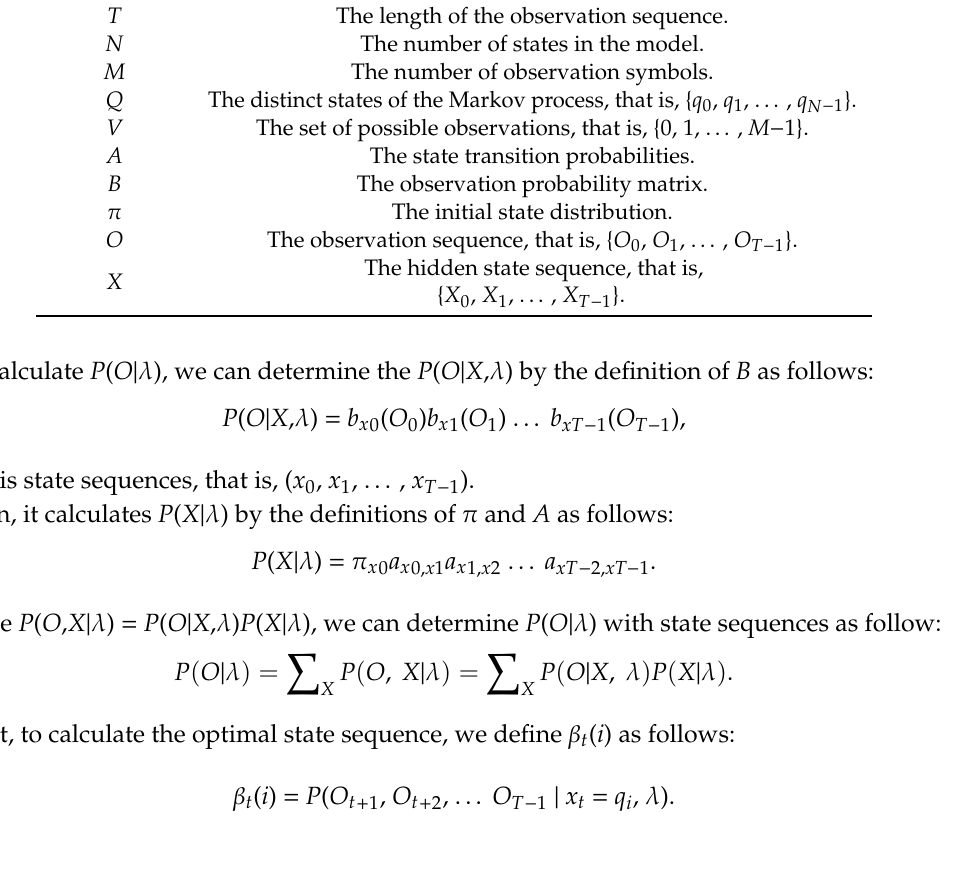
Figure 2. The hidden Markov model. Table 1. Notations in the hidden Markov model (HMM).